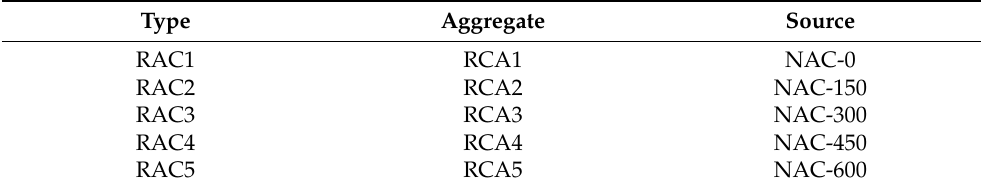
Table 3. The corresponding relationship among NAC, RCA and